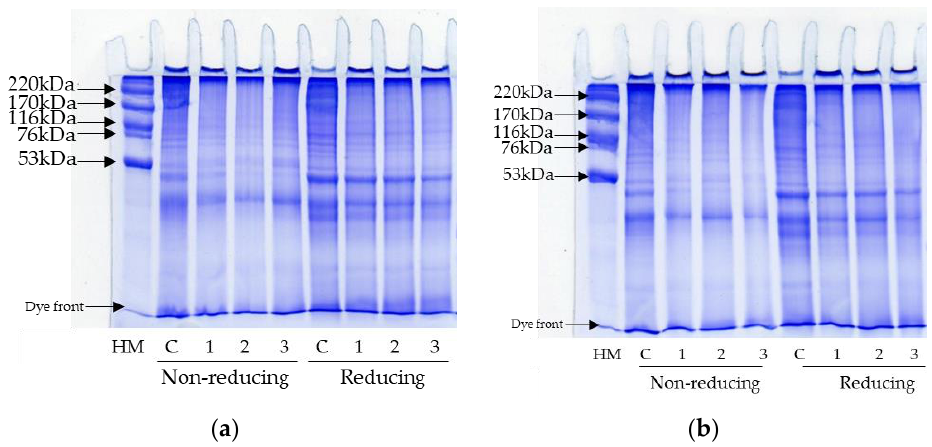
Figure 3. Protein patterns of ( a ) freeze-dried (FD) and ( b ) spray-dried (SD) fish myofibrillar proteins (FMP) modified with tannic acid (TA) at varying concentrations under non-reducing and reducing conditions. C: control sample (without TA), Number (1, 2, 3) denotes TA concentration of 0.125%, 0.25%, and 0.5%, respectively. HM: High molecular weight marker.